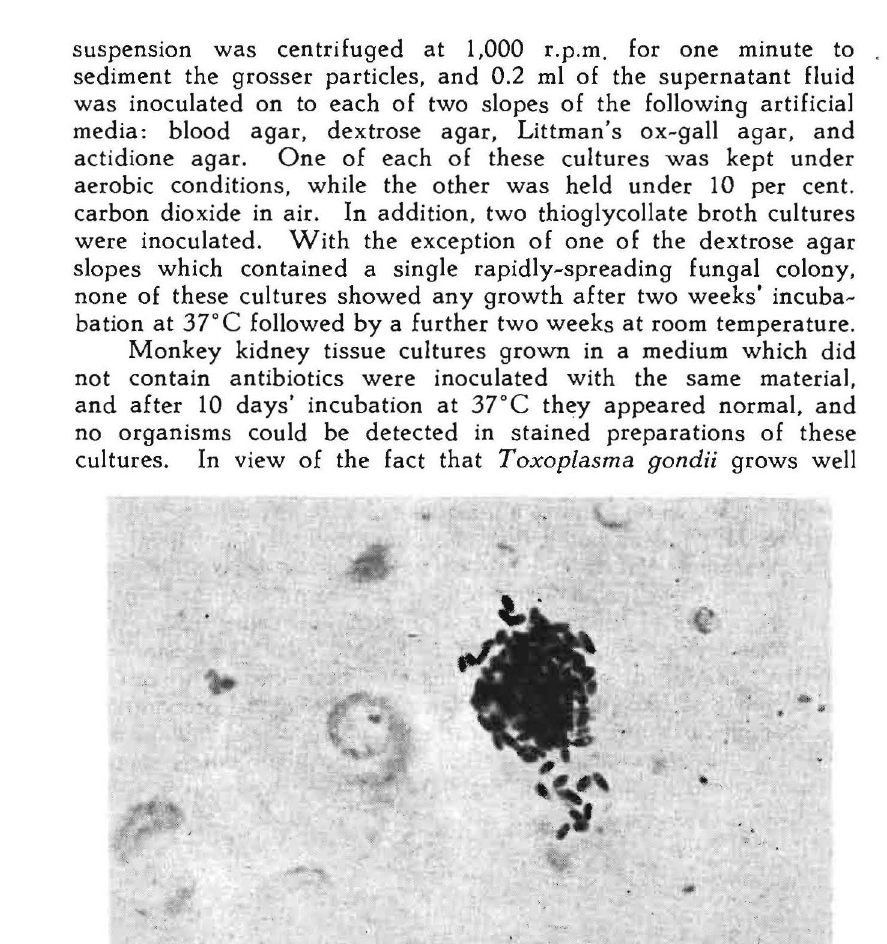
AGGREGATE OF E. CUNICULI IN BRAIN TISSUE. GOODPASTURE'S STIN. x